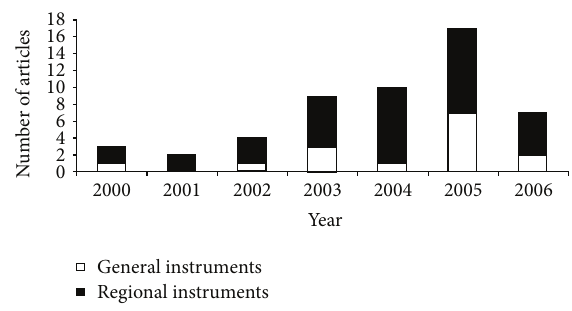
Figure 6: Distribution of general and region-specific instrument usage over time from 2000 to 2006 showing an increase in use of regional questionnaires between 2000 and